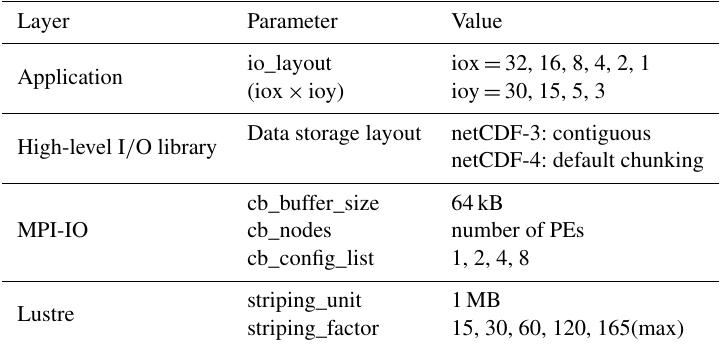
Table 2. The preselected parameters at all layers of I / O software stack.